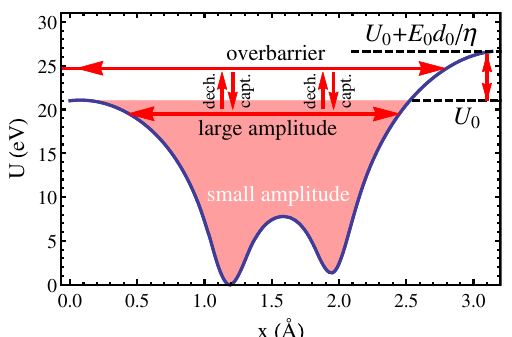
Fig. 9 Exponential fit of the depedence of the channeling efficiency in the penetration depth in Si and Ge crystals with the same parameters as in Fig. 7 and the same dependences without the overbarrier particles, captured under and escaped the channeling mode